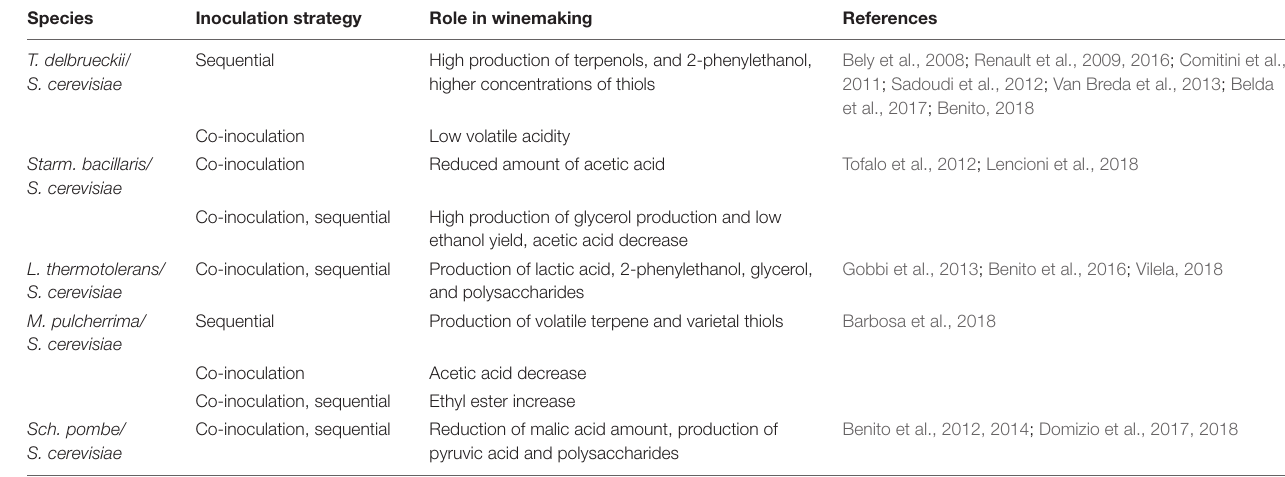
TABLE 1 | Main roles of non- Saccharomyces yeasts in winemaking.